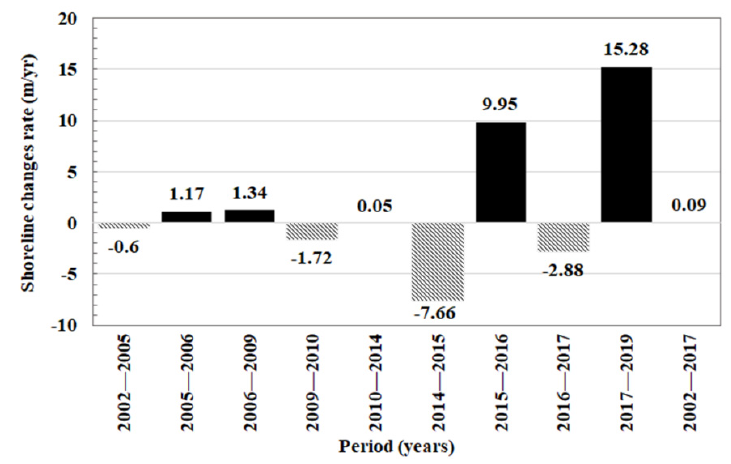
Figure 6. Rate of shoreline change at Pattaya beach.